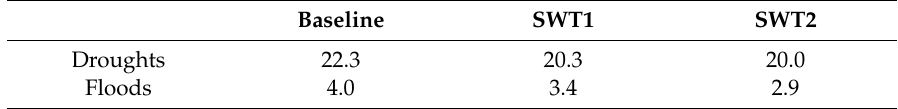
Table 6. Estimated economic losses associated with droughts and floods a ff ecting crop yields under the SWAT-modelled scenarios. The values are expressed in millions of U.S.